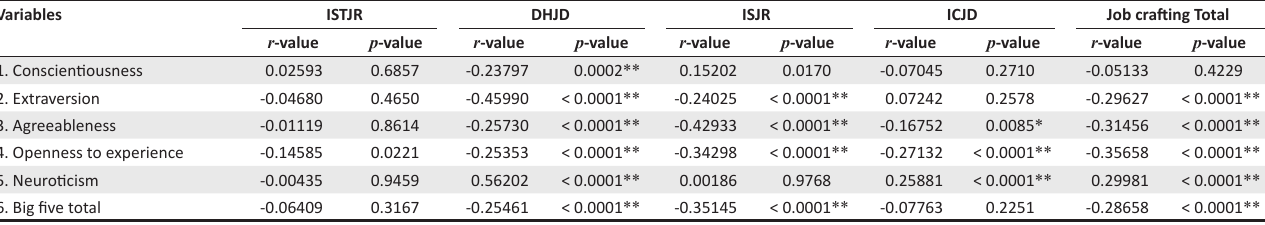
TABLE 4: Correlations matrix between big five factors and job crafting variables.